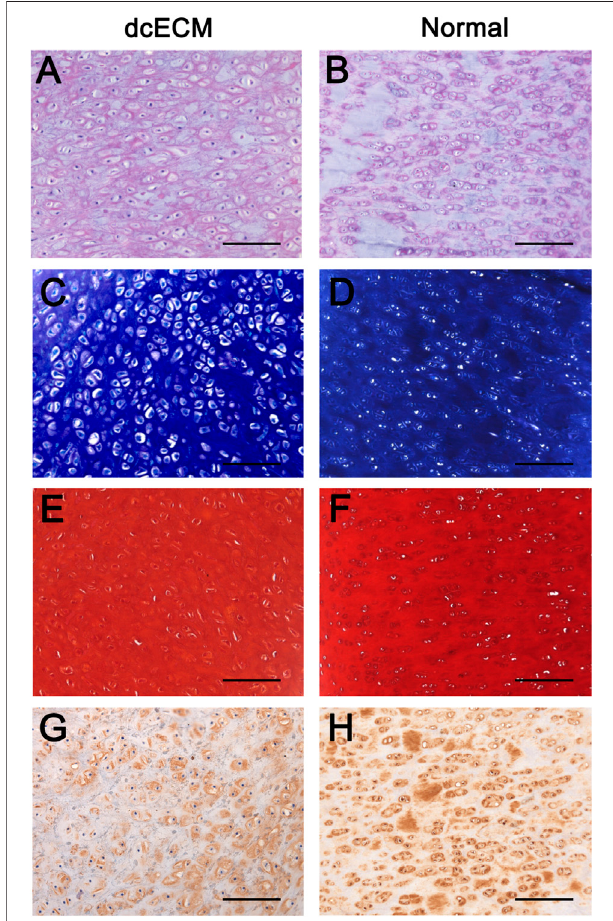
FIGURE 9 | Histological comparisons between grafts from dcECM hydrogels at 12 weeks after transplantation and normal ear cartilage tissue. Graftsof10 mg/mldcECMhydrogelswereharvestedat12 weeksafter invivo culture. (A, B) HE staining images of dcECM hydrogel grafts (dcECM) and normal cartilage tissues (Normal) from pig ears were compared. (C, D) Toluidine blue staining of samples from dcECM and Normal groups. (E, F) Safranin O staining of grafts from the dcECM group and tissues from the Normal group. (G, H) Comparison of collagen II expressions between grafts from the dcECM group and tissues from the Normal group. Scale bars (cid:2) 100 μ m.